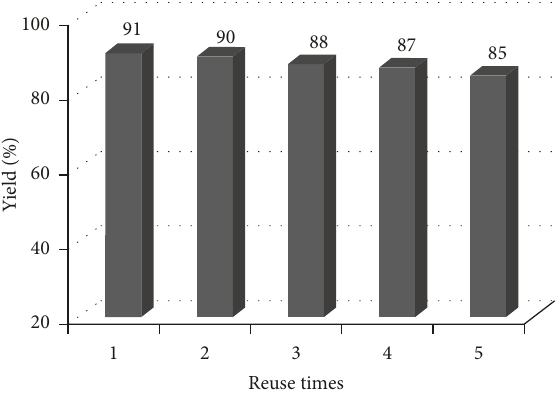
Figure 1: Reusability of the ionic liquid [DDPA][HSO 4 ].